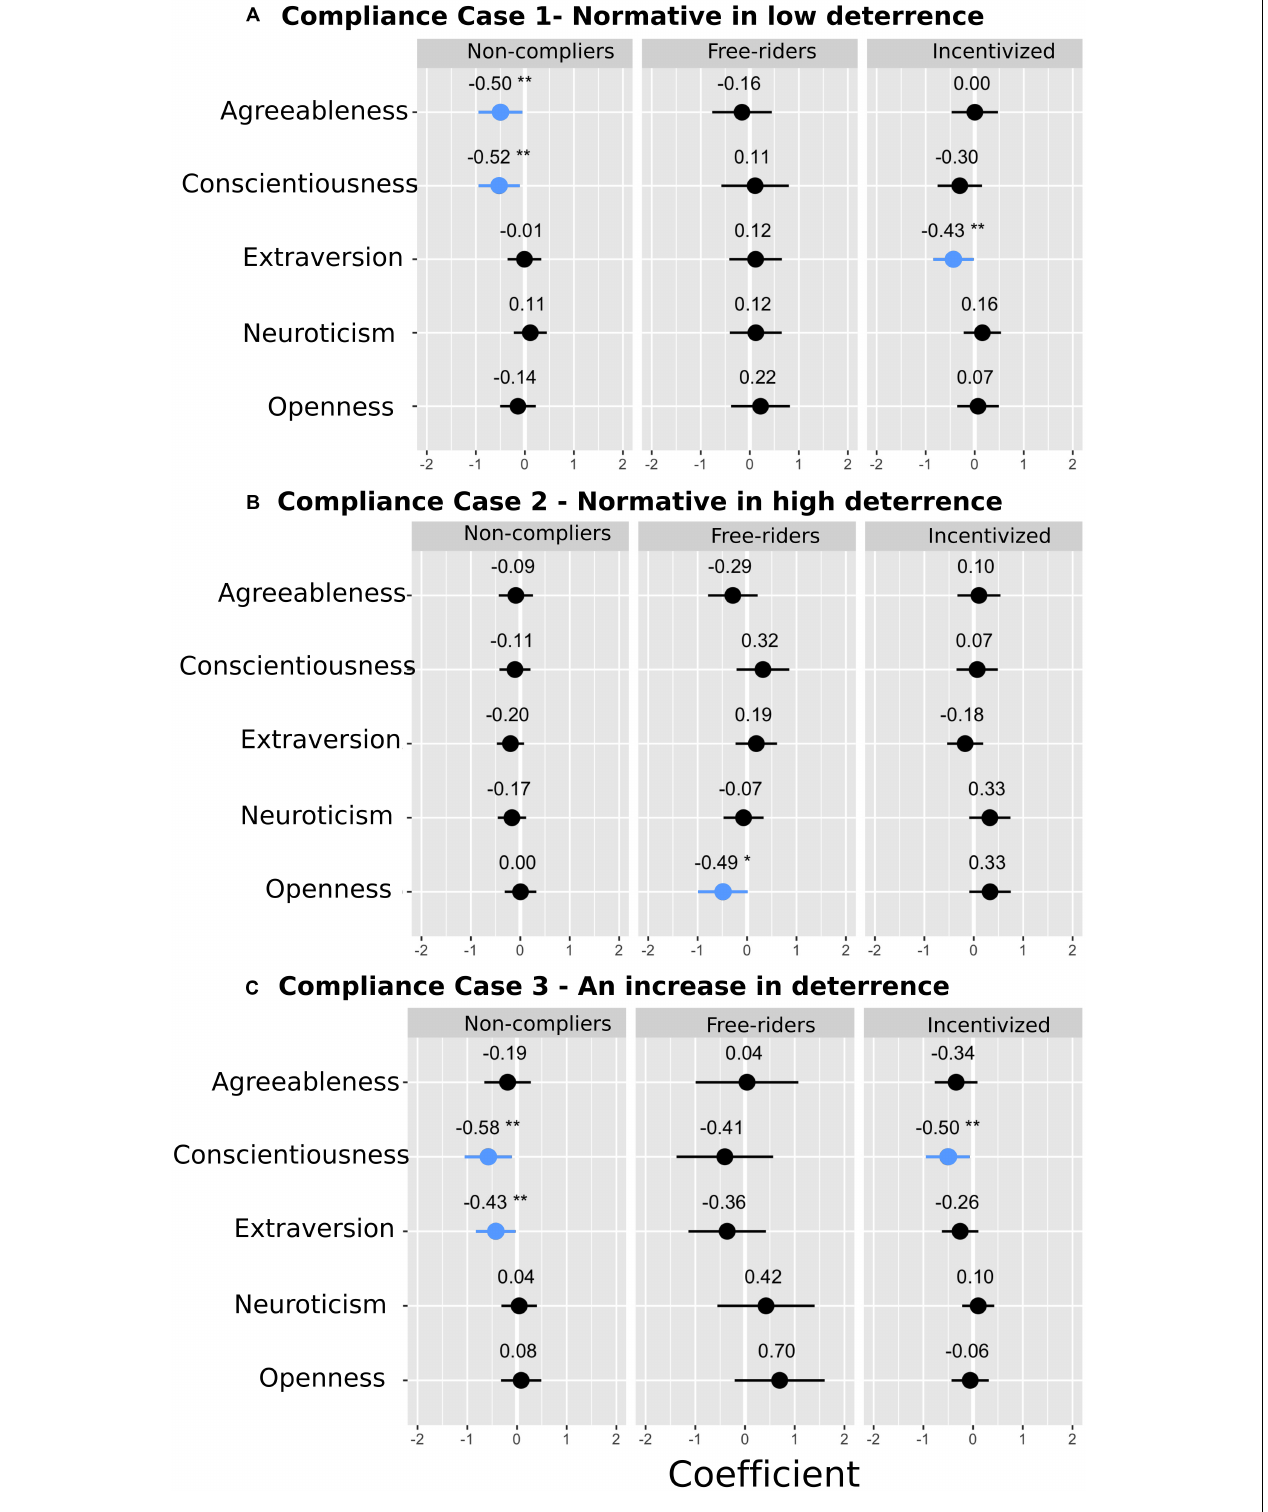
FIGURE 4 | Multinomial logit model results for personality types for non-compliers, free-riders, and the incentivized for (A) compliance case 1: normative message in low deterrence, (B) compliance case 2: normative message in high deterrence, and (C) compliance case 3: an increase in deterrence. Coefficients are included, and error bars indicate standard error. Significant coefficients are highlighted in blue, and significance level are: * p < 0.1; ** p < 0.05; *** p < 0.01. Full regression results are reported in Table 4 .